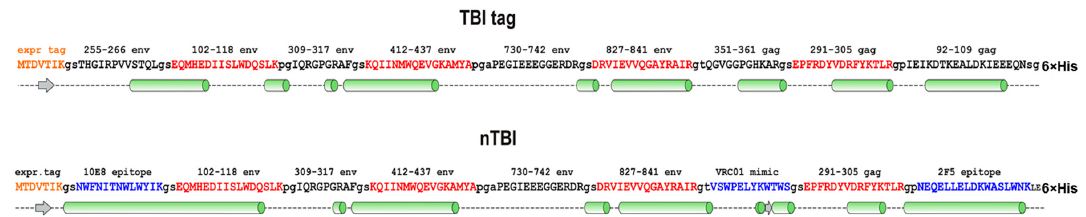
Figure 2. Depicting secondary structure of TBI_tag and nTBI proteins. The structures were predicted using the PSSpred tool available at [56]. bNAbs epitopes that were appended into the nTBI protein are highlighted with blue; T-h epitopes are marked with red; α -strings—light green cylinders; β -coils—grey arrows; unshaped structures—dashed lines. All proteins comprised a C-terminal sequence from histidine amino acid residues.